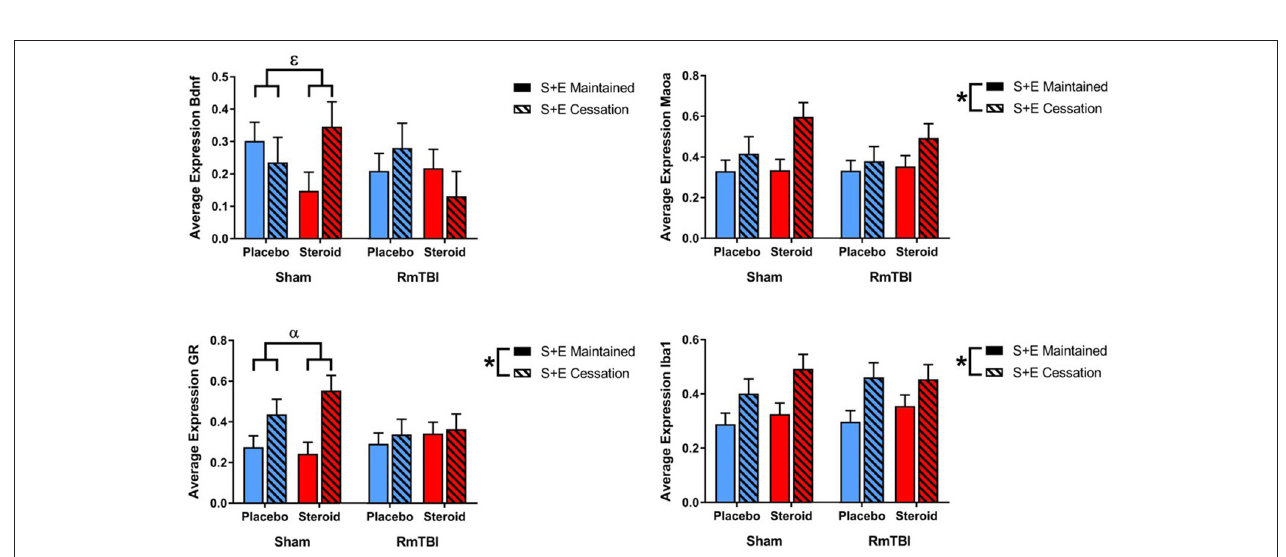
FIGURE 2 | Bar graphs displaying average mRNA expression levels in the PFC. Means ± standard error are displayed where *main effect for SEC, + main effect of Met treatment, and δ significant Met treatment by SEC interaction p ≤ 0.05. For Iba1 , post-hoc analysis demonstrated that the Met Treatment by SEC interaction was driven by animals exposed to AAS. Rats that were exposed to AAS and exercise and then subsequently quit, exhibited increased expression of Iba1 , when compared to rats that were exposed to AAS and exercise throughout the experiment, p = 0.04. mRNA, messenger RNA; PFC, pre-frontal cortex; RmTBI, repetitive mild traumatic brain injury; S + E, steroid and